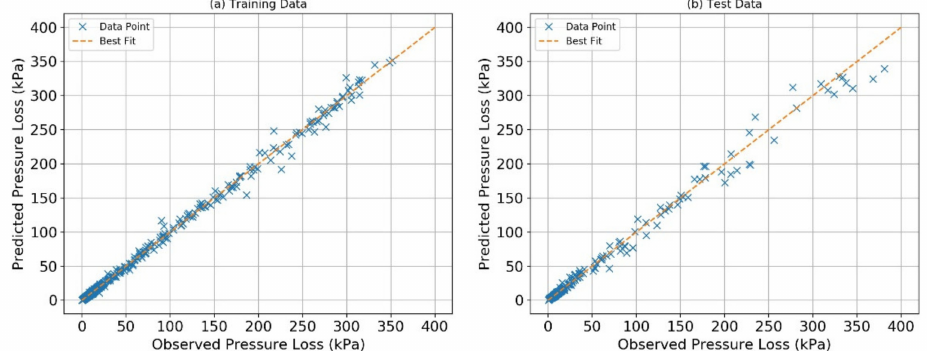
Figure 7. Random Forest predicted pressure plotted with observed pressure loss: ( a ) training dataset and ( b ) test